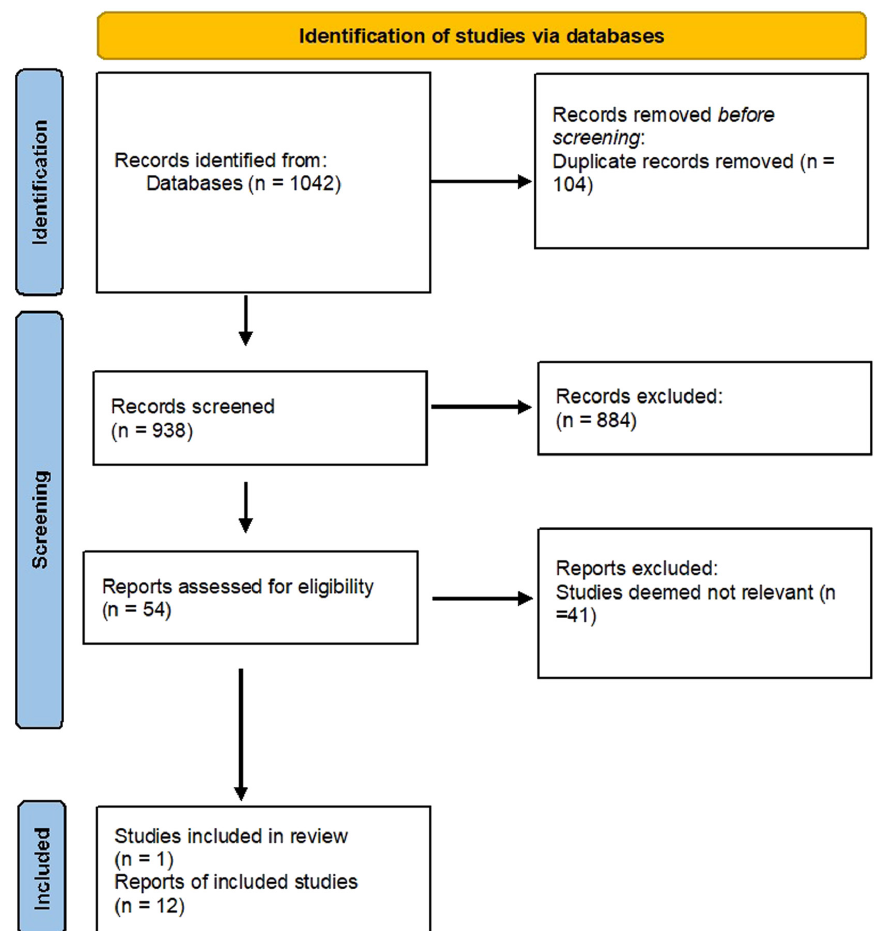
Figure 2. Flow diagram of the selected